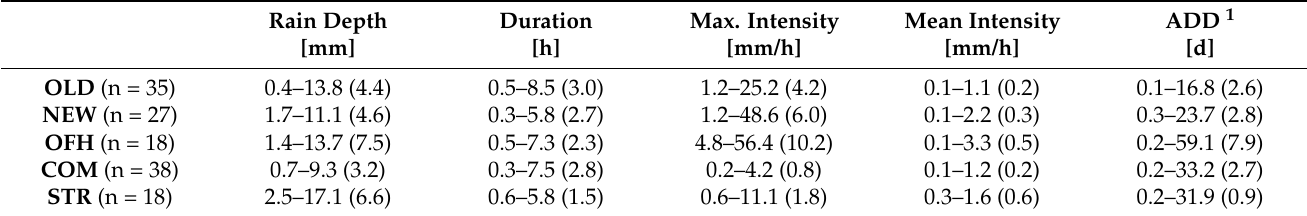
Table 2. Rain event characteristics of sampled events. Min–max (median).